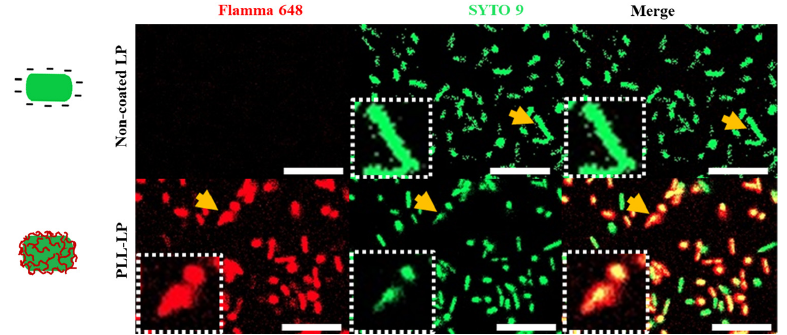
Figure 2. Confocal laser scanning micrographs of non-coated LP and PLL-LP stained with Flamma ® 648 NHS ester fluorescence dye (red signal) and SYTO 9 (green signal) for conjugation with the -NH 2 group of PLL and for the shape of the probiotics cells, respectively. The yellow arrows indicate the magnified L. plantarum in the white-dotted squares. The scale bar represents 10 μ m.